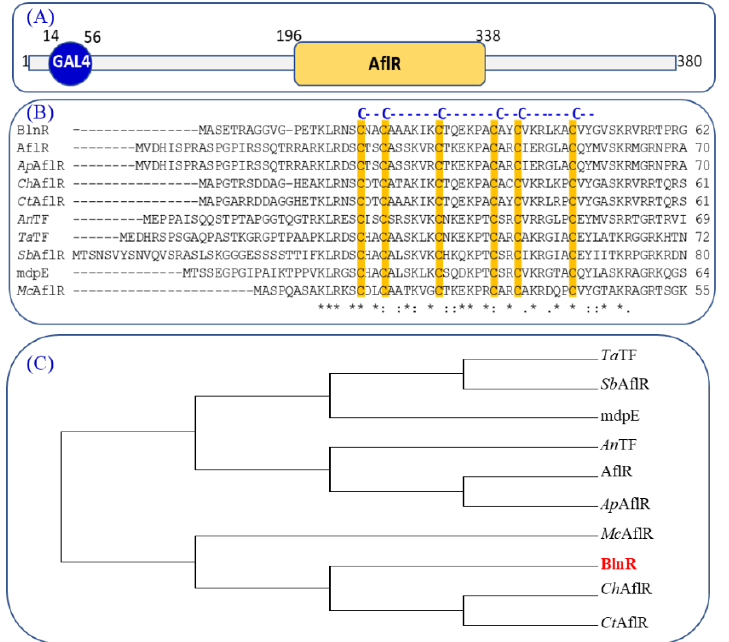
Figure 2. Characterization of regulator BlnR and its phylogenic analysis. ( A ) Domain characterization of regulator BlnR. ( B ) Alignment analysis of the conserved cysteine amino acids. ( C ) Evolutionary phylogenetic analysis by maximum likelihood method using MEGA 7.0 software. The evolutionary history was inferred using the maximum likelihood method based on the JTT matrix-based model: Ta TF (accession no. XP_040731924.1), Sb AflR (accession no. ESZ98975.1), mdpE (accession